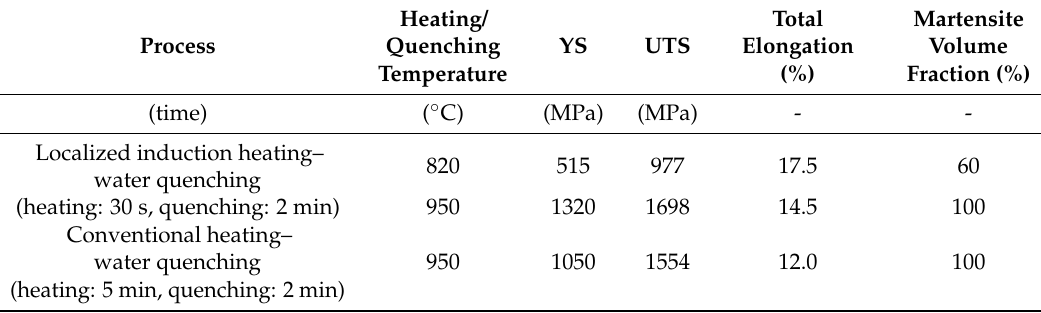
Table 3. Mechanical properties of hardened samples from different processes. UTS—ultimate tensile stress, YS—yield strength/R p0.2